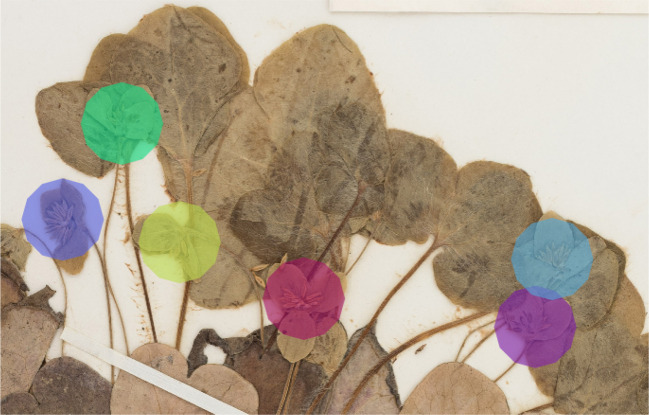
Example of a specimen of the training set containing six reproductive structures (flowers) marked by dodecagons.